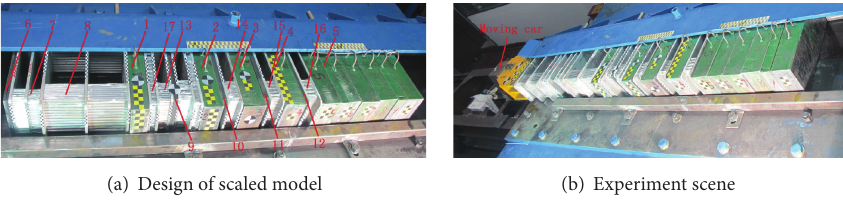
Figure 2: Scaled train collision test.